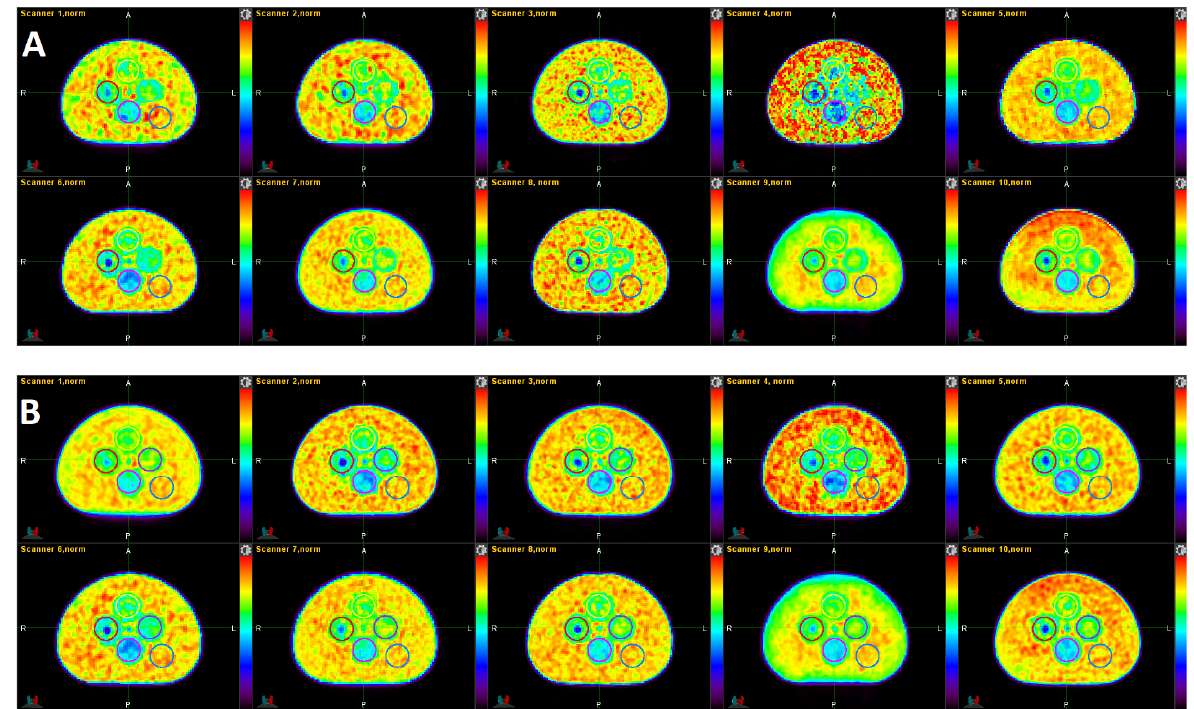
Figure 2. Single slices of the standard ( A ) and harmonized ( B ) datasets. The order of the images follows the order in Table 1 (scanner 1 to 10 from top left to bottom right). The images were normalized by the mean activity of their respective background (Pattern-ROI 5). The displayed color scale is identical for all images and ranges from 0 (black) to 1.22 (red).